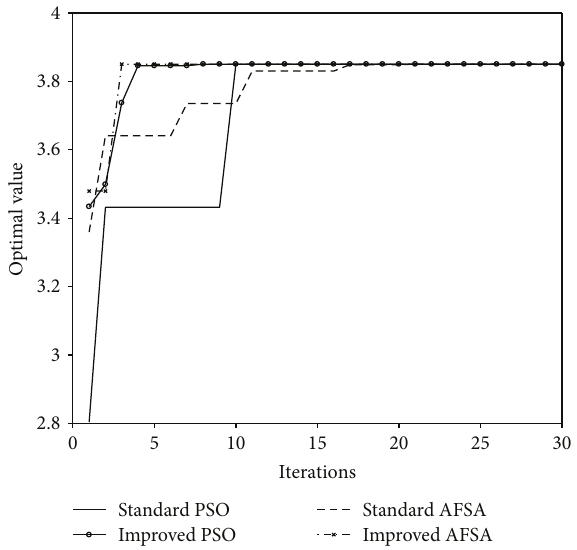
Figure 1: Iterative evolution curves of test function.